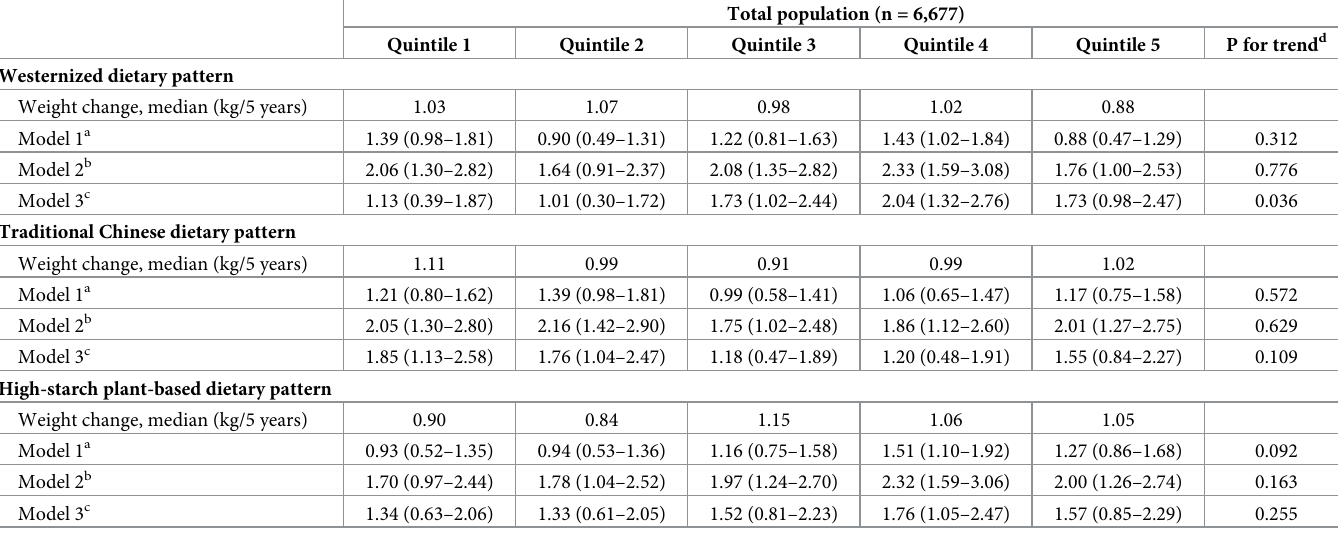
region in this study, there was a more pronounced association between the Westernized die- tary pattern and weight gain (P for trend < 0.001) compared to the Northern region (Table 6). When stratified by age, the association between the Westernized dietary pattern and weight gain was limited to young adults. In four sensitivity analyses in which, we 1) censored the data at age 65 years during the fol- low-up, 2) excluded participants whose baseline BMIs were > 30 kg/m 2 , or 3) excluded partici- pants whose follow-up periods were less than three years, or 4) participants who were in the 1 st or 99 th percentile of weight change (S7–S10 Tables), the point estimates were in the same direction as the estimates observed in the main analysis. Table 5. Least-squares means of body weight change (kg/5 years) according to quintiles of dietary patterns in men and women combined. Total population (n = 6,677) Quintile 1 Quintile 2 Quintile 3 Quintile 4 Quintile 5 P for trend